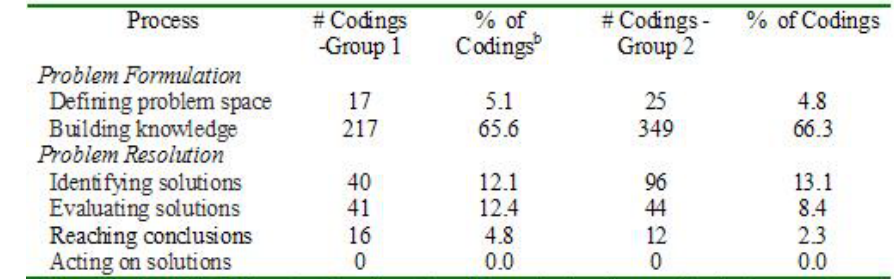
Table 3. Coding of PFR Processes in AgroEcology Case 2 Group 2- Second